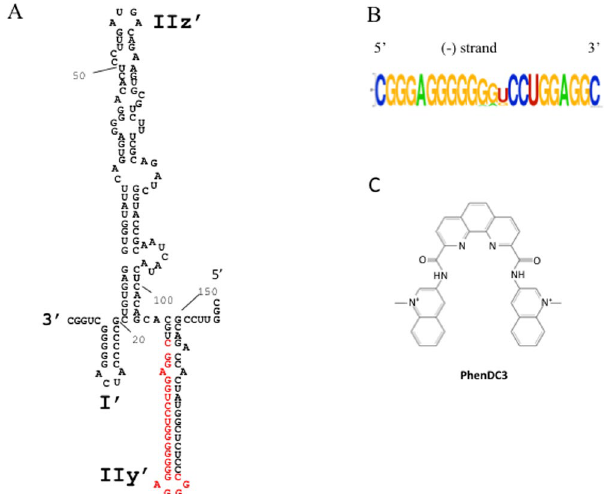
Figure 1. ( A ) Predicted secondary structure of the 3 ′ end 157 nucleotides of the HCV ( − )RNA according to Smith et al . 21 . The putative G4 forming sequence used for the biophysical experiments (HCV110-131) is highlighted in red. ( B ) Logo representation of the detected putative G4 sequence by G4Hunter algorithm (WebLogo application). ( C ) Chemical structure of PhenDC3 G4